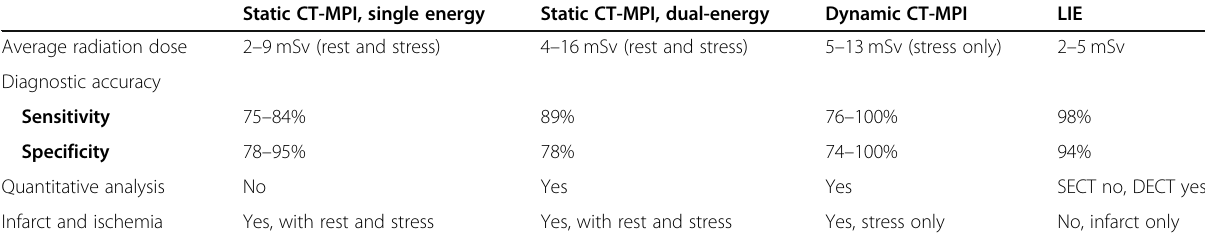
Table 1 Specification overview of different CT techniques Static CT-MPI, single